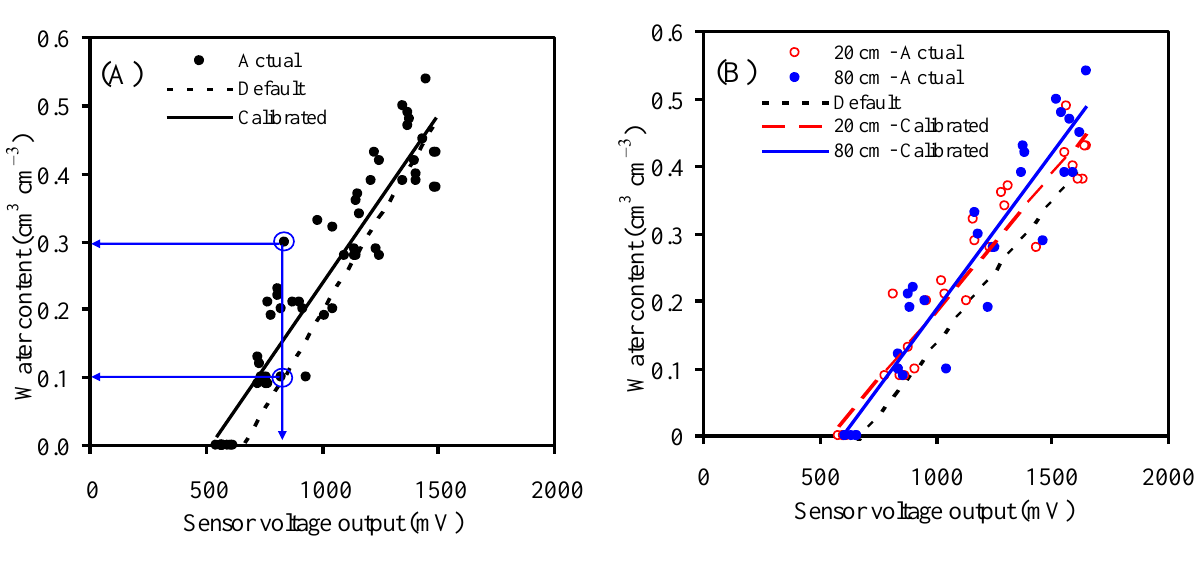
Figure 4. Actual soil water content as a function of the readings of the EC10 ( A ), EC-20 ( B ), and ML2x ( C ) using soil samples from 20 and 80 cm depths across the watershed. Arrows connecting actual water content data points (circled blue) with x and y axes in 4A show an example of absolute error from EC-10 as it gave same reading ( ca. 830 mV) for 0.1 and 0.3 cm 3 cm −3 water contents resulting in 20%